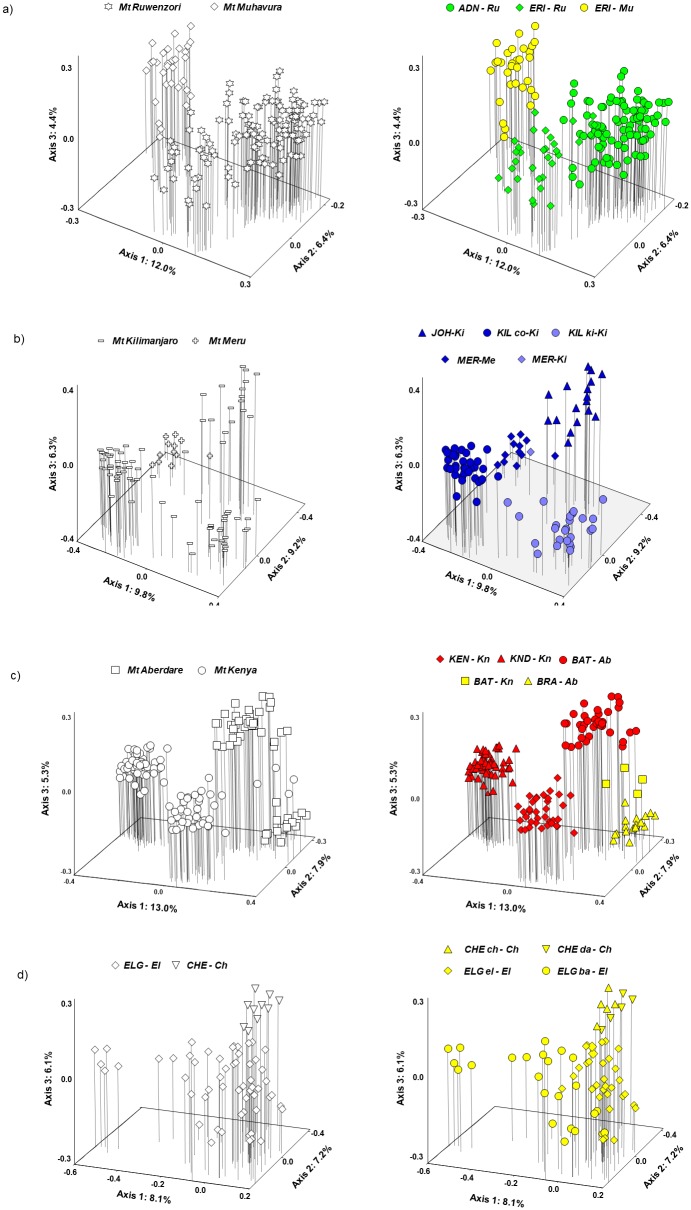
Separate principal coordinates analyses (PCoA) based on Dice’s coefficient of similarity between AFLP phenotypes for subsets of the total dataset representing each of the four main mountain groups.Plots to the left show mountains, plots to the right show taxonomic annotations. Abbreviations as in Fig 2, except in 4b where KIL co-Ki (D. kilimanjari ssp. cottonii), KIL ki-Ki (D. kilimanjari ssp. kilimanjari) and in 4d where CHE ch-Ch (D. cheranganiensis ssp. cheranganiensis), CHE da-Ch (D. cheranganiensis ssp. dalei), ELG el-EL (D. elgonensis ssp. elgonensis) and ELG ba-EL (D. elgonensis ssp. barbatipes) as indicated in S1 Appendix.